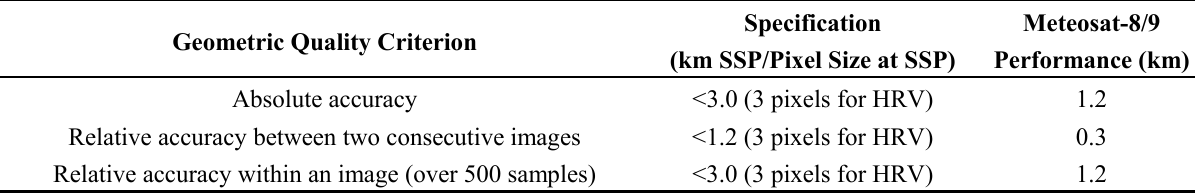
Table 2. Geometric rectification accuracy specification and performances of SEVIRI level 1.5 data provided by the European Organization for the Exploitation of Meteorological Satellites (EUMETSAT)